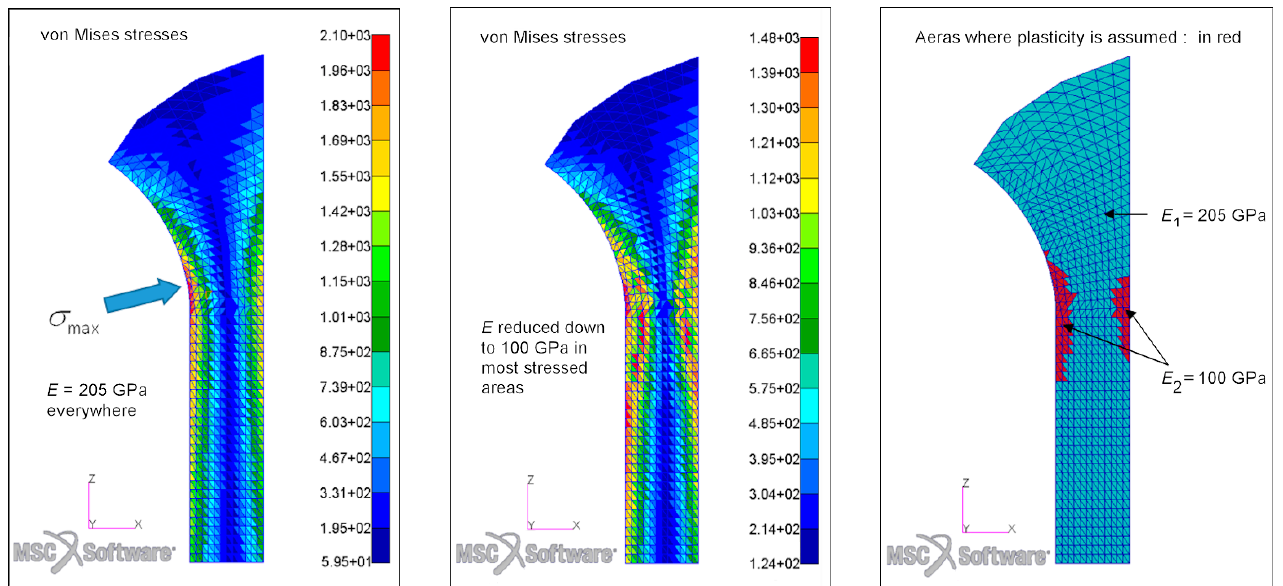
Figure 13. Results from stress analysis of the collarette at F = 10 daN with a mesh axisymmetric model. For a constant modulus E = 205 GPa everywhere, the scale shows a maximum stress σ max = 2100 MPa ( left ). Due to the overpassed limit stress of the material compared to σ ult , we take into account the creeping effect—or fluage —by artificially introducing a smaller modulus E = 100 GPa in the most stressed zones. We obtain, from Nastran, a more realistic stress distribution, where σ max ≤ 1480 MPa ( center and right ).